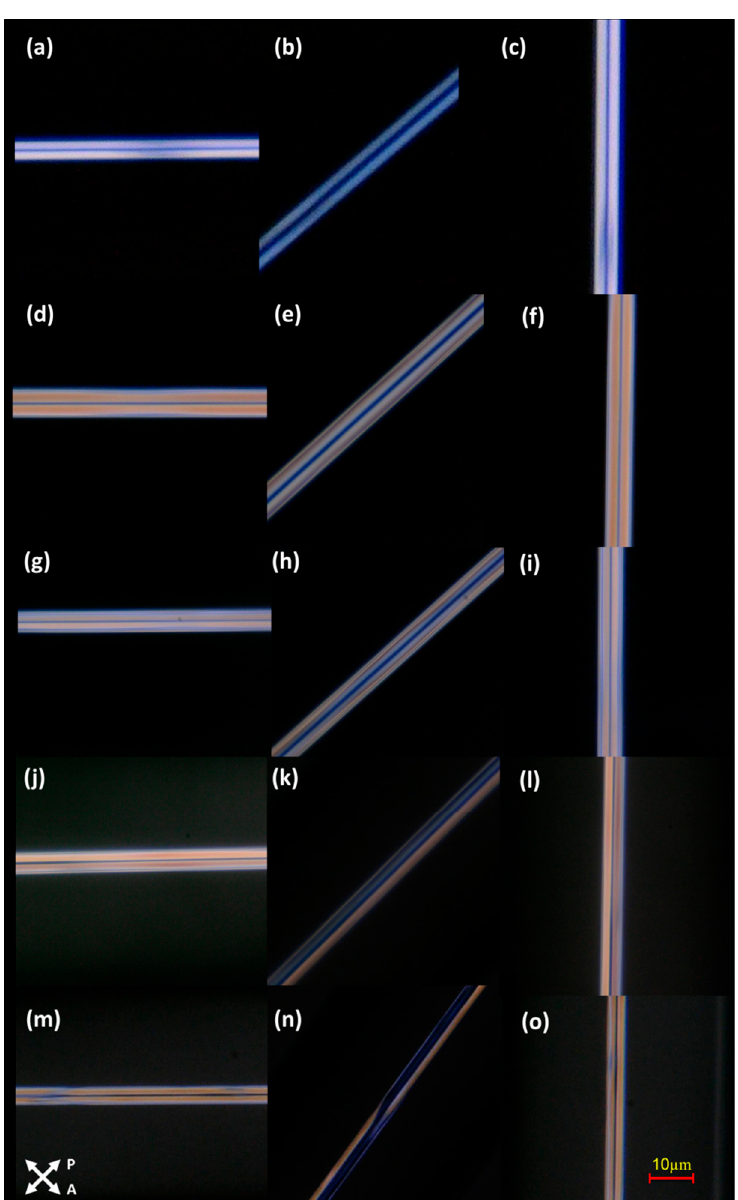
Figure 2. The optical image under the microscope with crossed polarizers for 3- µ m microcapillaries MCs infiltrated with undoped W212 ferroelectric liquid crystal FLC ( a – c ) and doped with gold nanoparticles GNPs at concentrations of 0.1% wt. ( d – f ), 0.2% wt. ( g – i ), 0.3% wt. ( j – l ), 0.5% wt. ( m – o ).